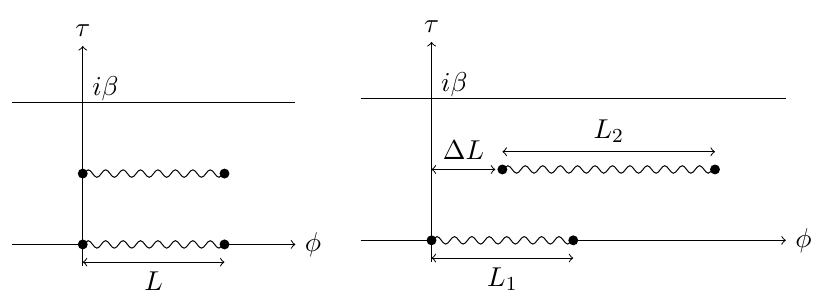
Figure 3 . Twist operator insertions on the Euclidean cylinder for the computation of the entangle- ment entropy of an interval which consists of two disconnected components on the two asymptotic boundaries. L.h.s. : computation of [11], both components of the entangling interval are of the same size and at the same position; r.h.s. : position and size of both parts is